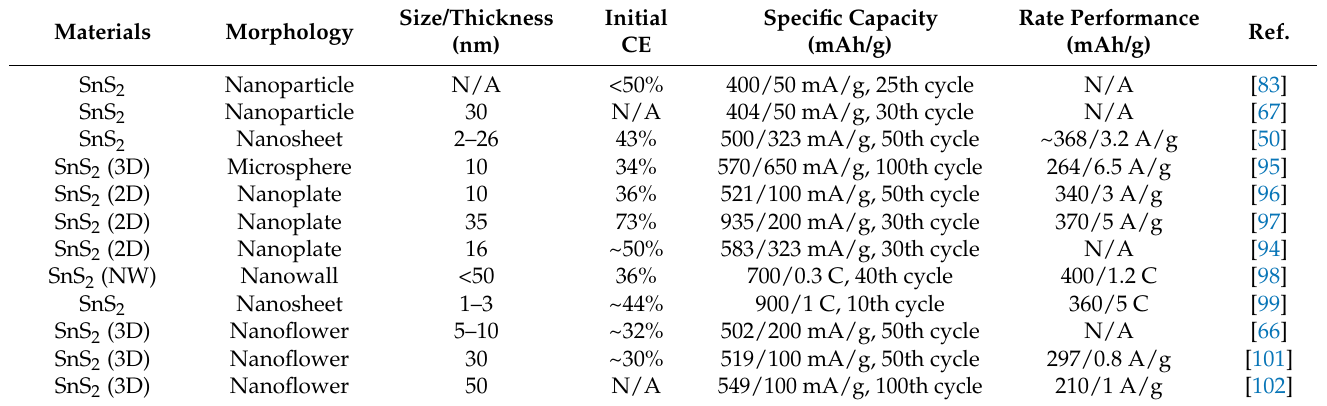
Table 1. Electrochemical performance of pure SnS 2 -based anodes with various